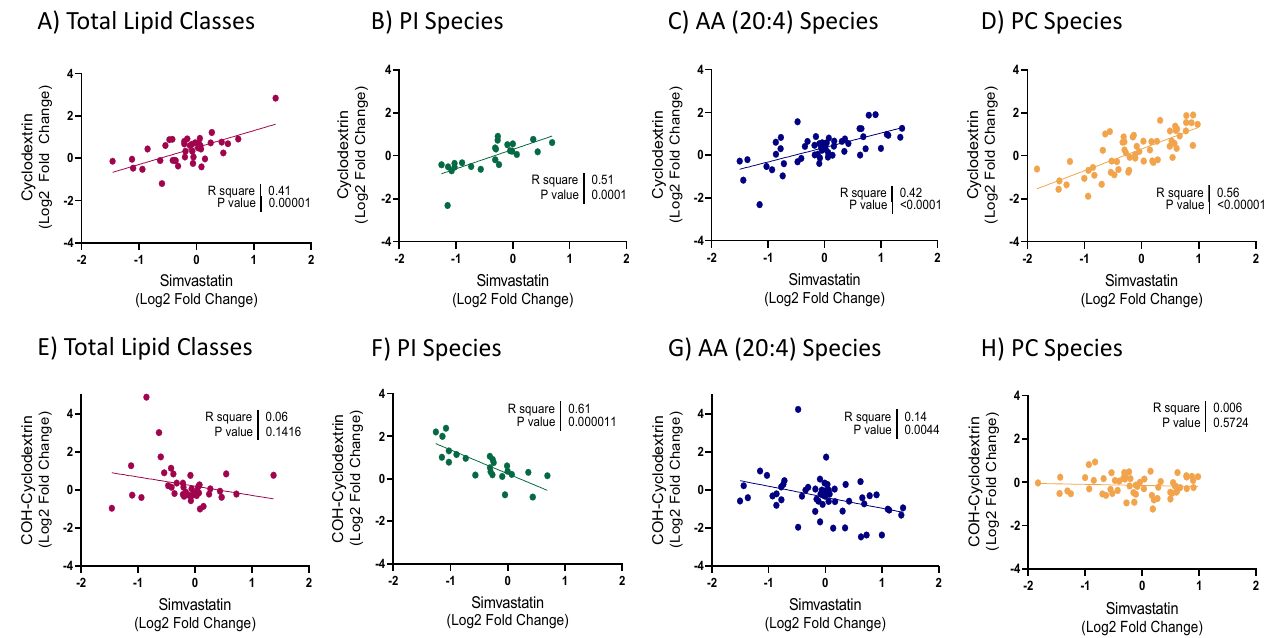
Figure 2. Correlation of changes in lipid species between treatments: Unadjusted linear associations between 5 μ M simvastatin and 20 mg/mL cyclodextrin for ( A ) total lipid classes; ( B ) phosphatidylinositol (PI) species and ( C ) species containing arachidonic acid (AA; 20:4) and ( D ) phosphatidylcholine (PC) species; or 20 mg/mL COH-cyclodextrin for ( E ) total lipid classes; ( F ) phosphatidylinositol (PI) species; ( G ) species containing arachidonic acid (AA; 20:4) and ( H ) phosphatidylcholine (PC) species;log2 fold difference denotes the percentage between 5 μ M simvastatin, 20 mg/mL cyclodextrin or 20 mg/mL COH-cyclodextrin treatments, relative to control. Data presented as log2 fold difference.